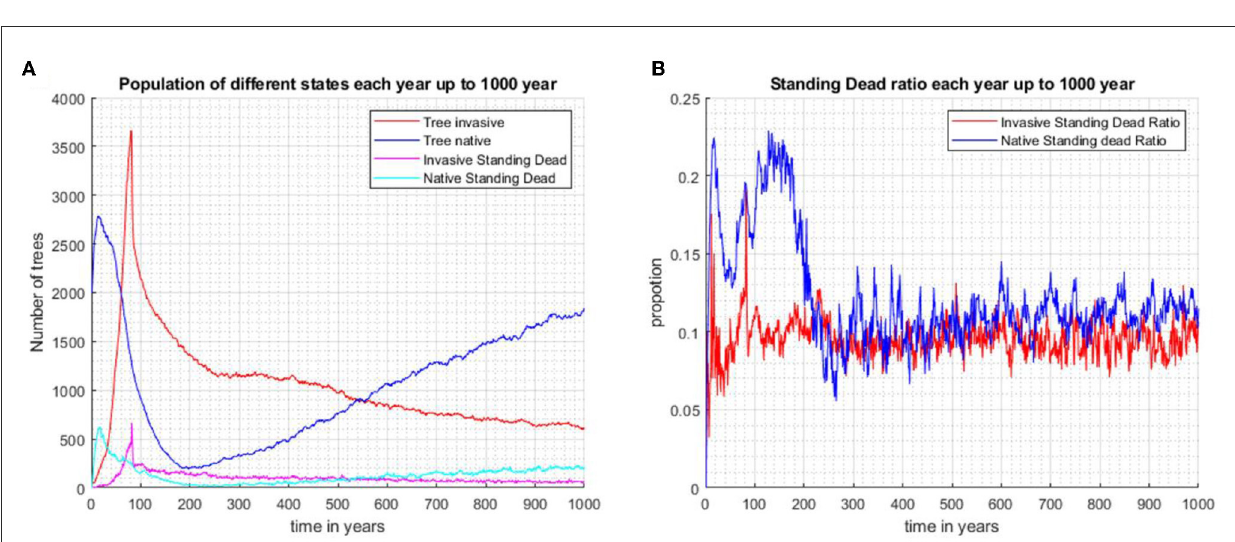
FIGURE5 When the two species are initially randomly distributed across the same area and biocontrol is introduced after 80 years, the invasive species is seen to gradually decline and the community becomes mostly dominated by the increasing population of native species after 1,000 years (Scenario 3). (A)